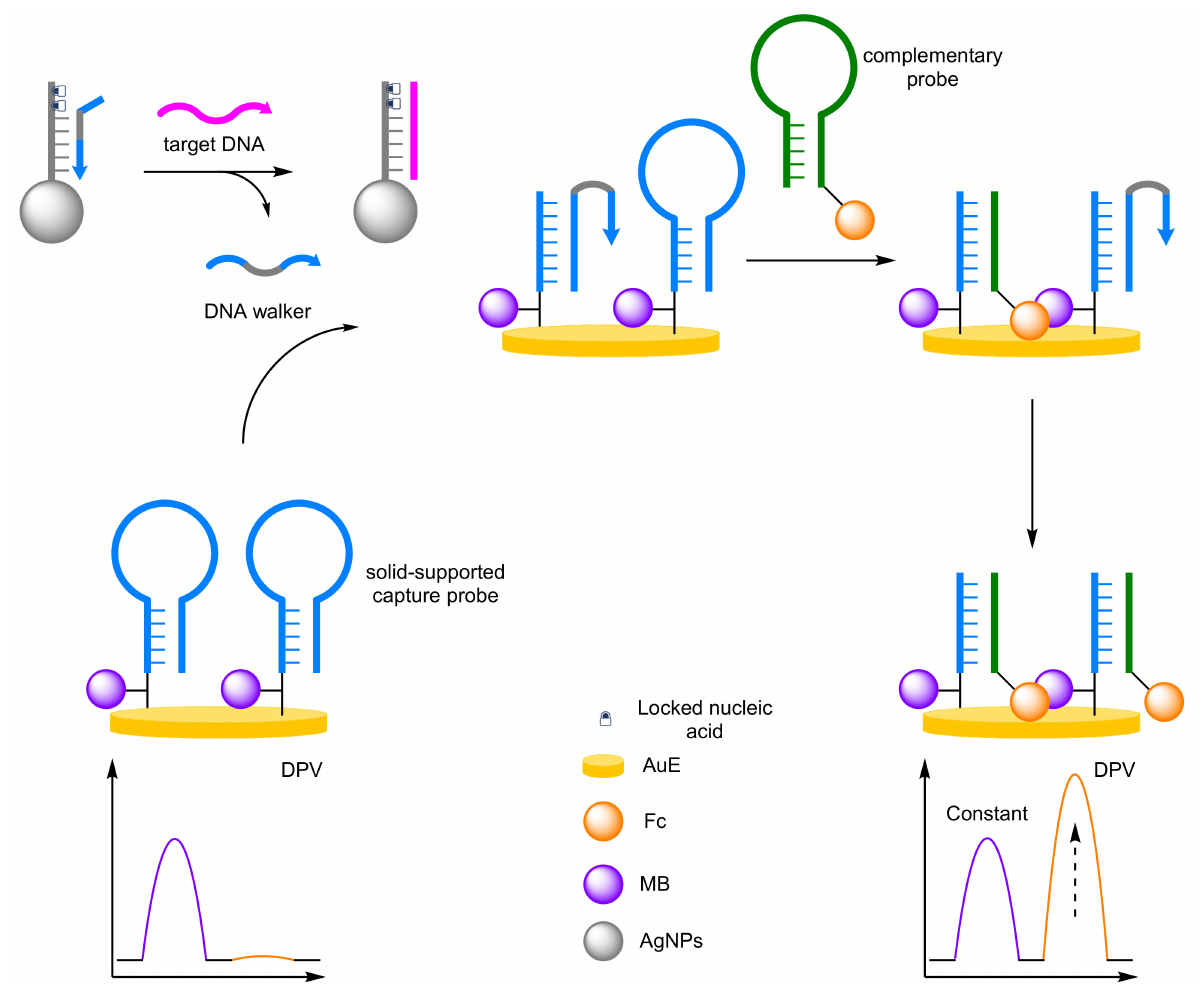
Figure 21. Schematic representation of a DNA walker-based biosensor.